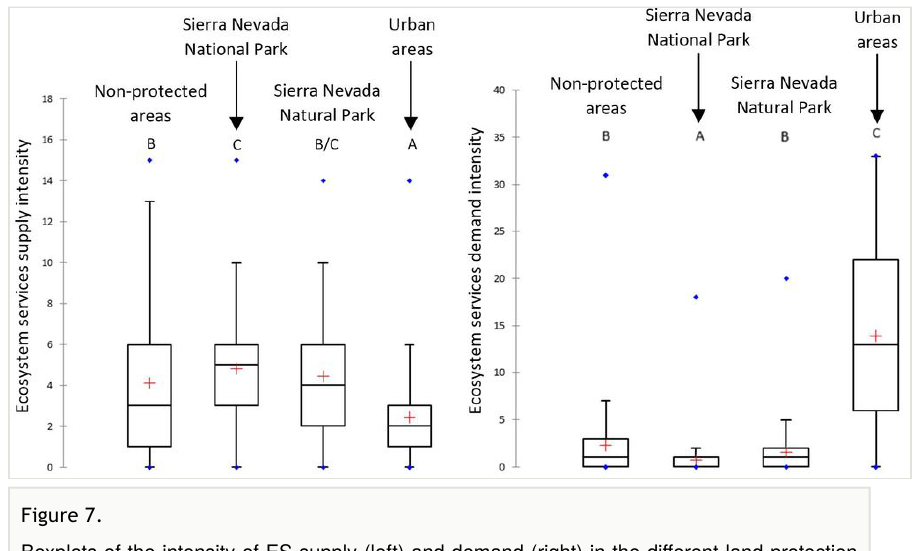
Figure 7. Boxplots of the intensity of ES supply (left) and demand (right) in the di ff erent land protection categories of the study area. Capital letters below the name indicate if there is any statistically signi fi cant di ff erence between the areas (di ff erent letter) or not (same letter) with a signi fi cance level of